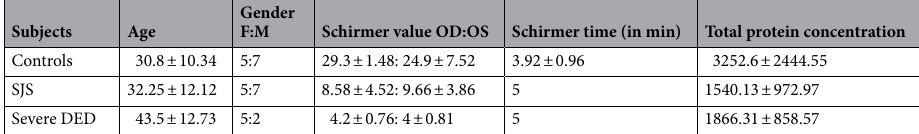
Pro-inflammatory cytokines in chronic SJS tears. We observed significant upregulation of pro- inflammatory cytokines IL-6 (p-value ≤ 0.029), CXCL8/IL-8 (p-value ≤ 0.009), IL-1β (p-value ≤ 0.041) and IL-2 (p-value ≤ 0.025) in tears of chronic SJS patients when compared to controls. There is no significant difference